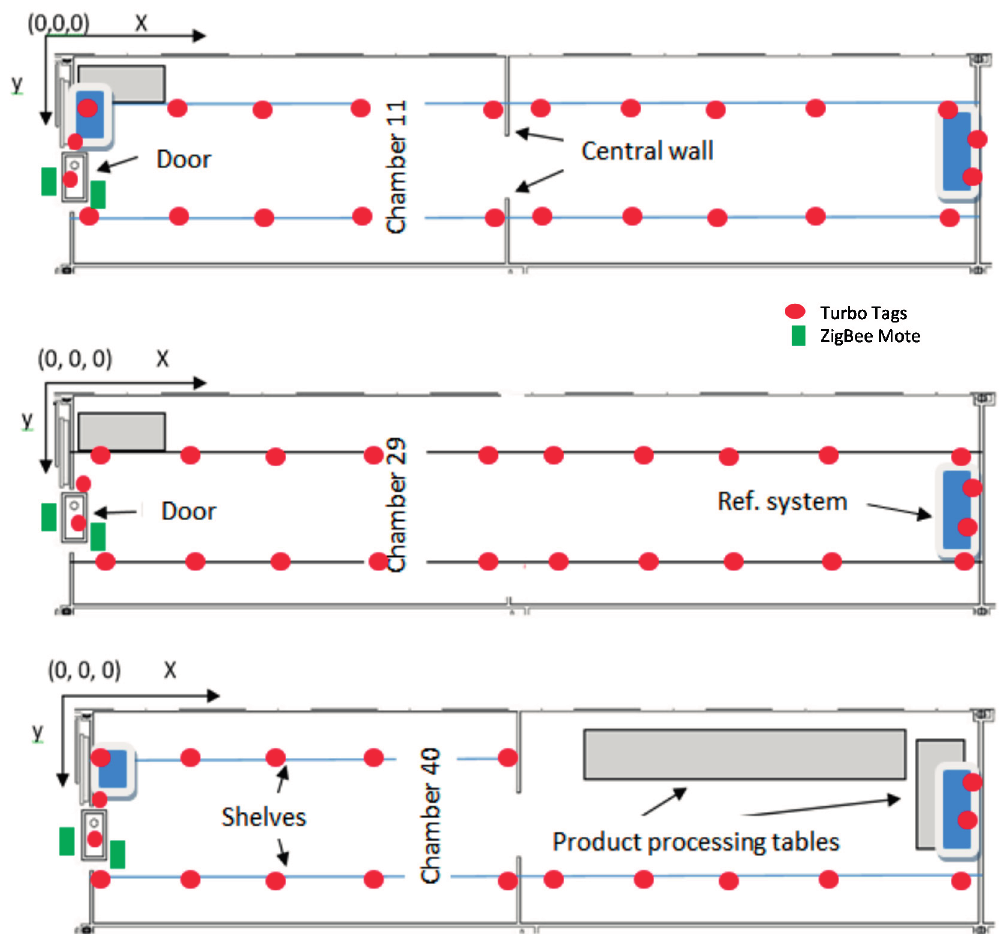
Figure 1. Scheme of the cold rooms and sensor